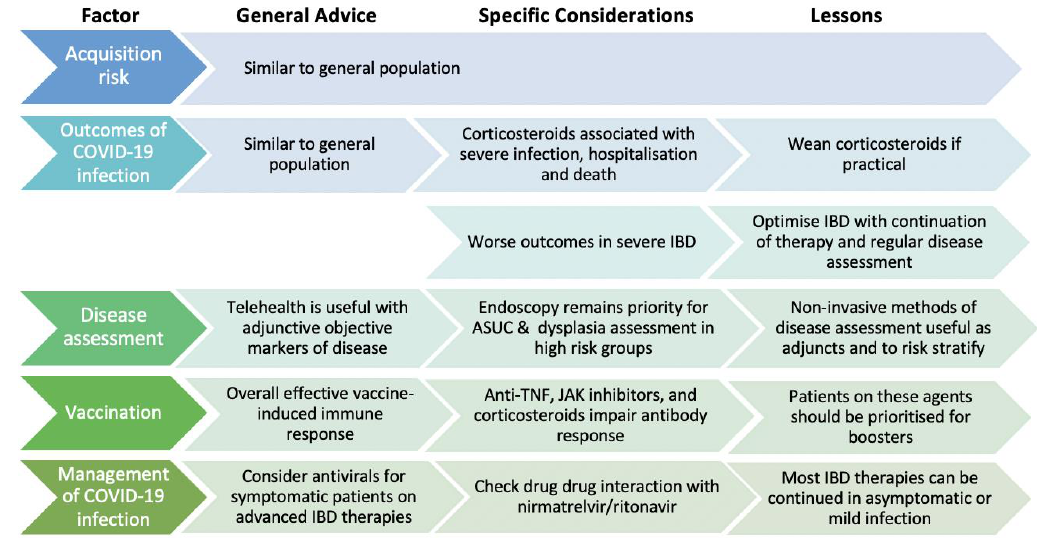
Figure 1. Considerations in the care of inflammatory bowel disease patients surrounding the SARS- CoV-2 pandemic.